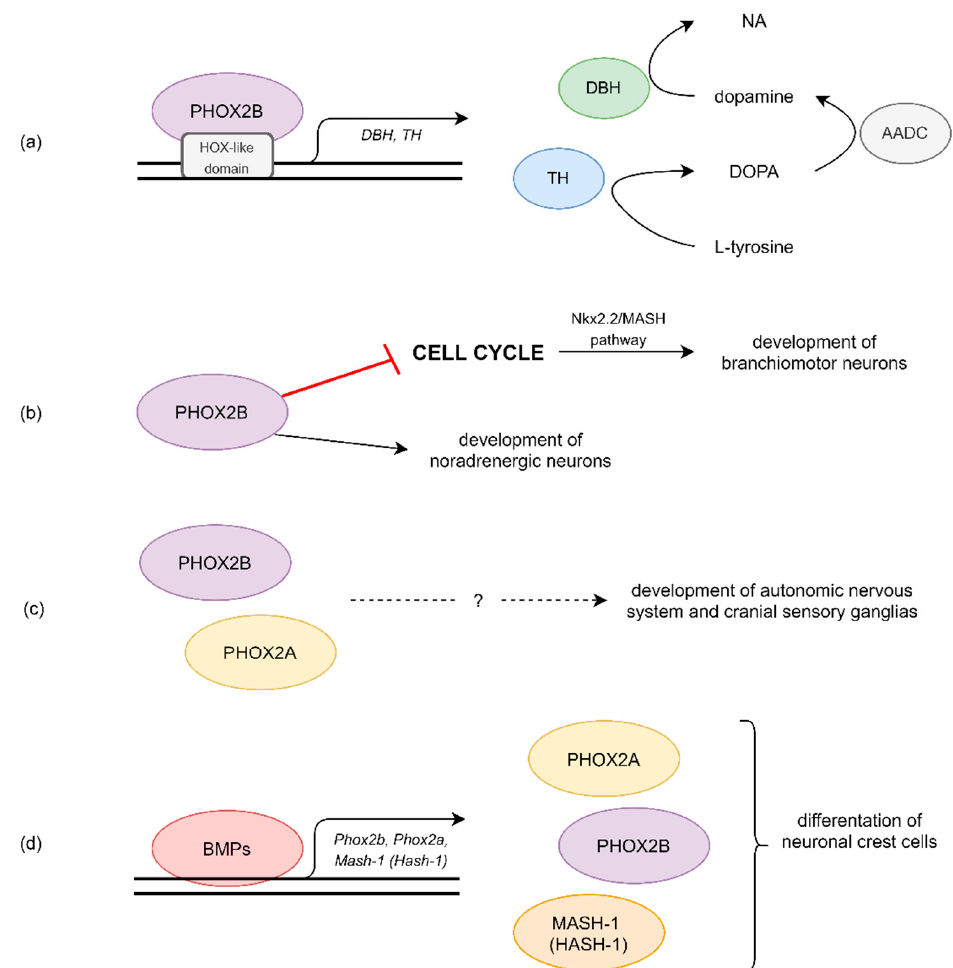
Figure 1. Possible pathomechanisms of CCHS. ( a ) HOX-like domain of PHOX2B binds to promotors of NA synthesis genes, such as DBH and TH, leading to their expression. ( b ) PHOX2B arrests some cell cycle in brain, what enables proper development of branchiomotor neurons. Similarly, it also has impact on development of noradrenergic neurons. ( c ) PHOX2A and PHOX2B expression was detected in the autonomic nervous system and cranial sensory ganglia of a fetus from the beginning of the formation at least to the middle of the gestation period. ( d ) BMPs promotes expression of neuronal crest cells differentiational factors, such as PHOX2A, PHOX2B and MASH-1 (HASH-1).